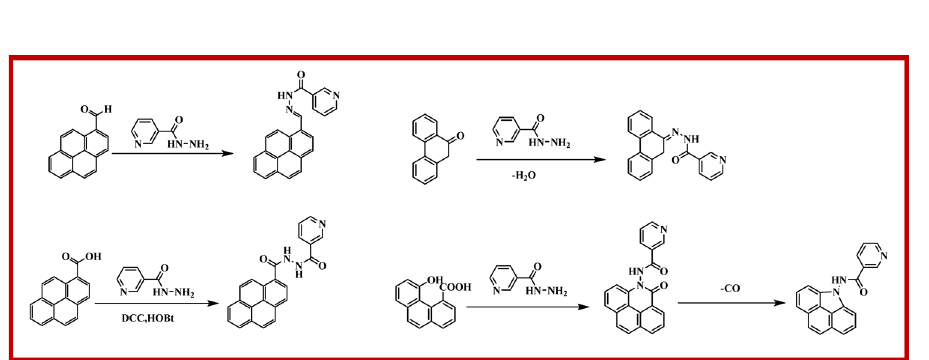
Figure 7. Reactions occur during the synthesis of